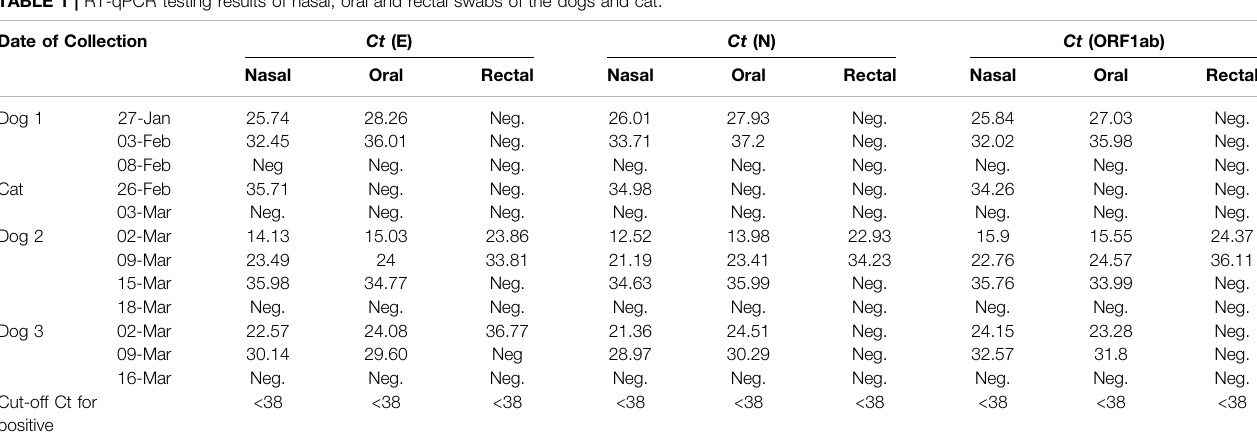
TABLE 1 | RT-qPCR testing results of nasal, oral and rectal swabs of the dogs and